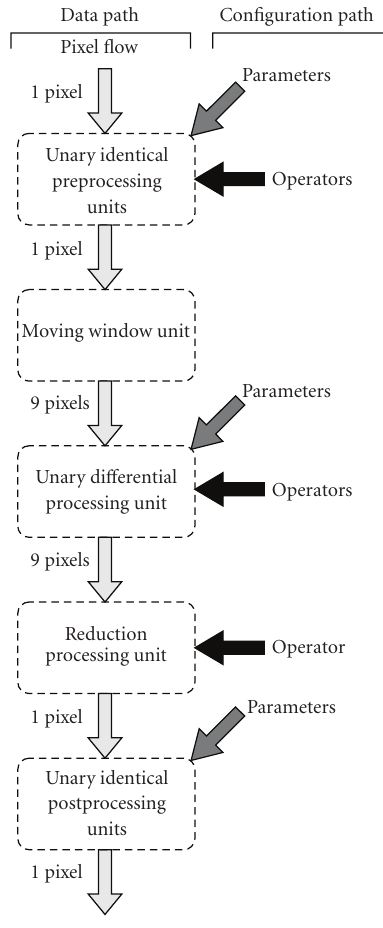
Figure 2: Decomposition of the image processing module into con- figurable units. On the right-hand side, configuration possibilities are expressed for each